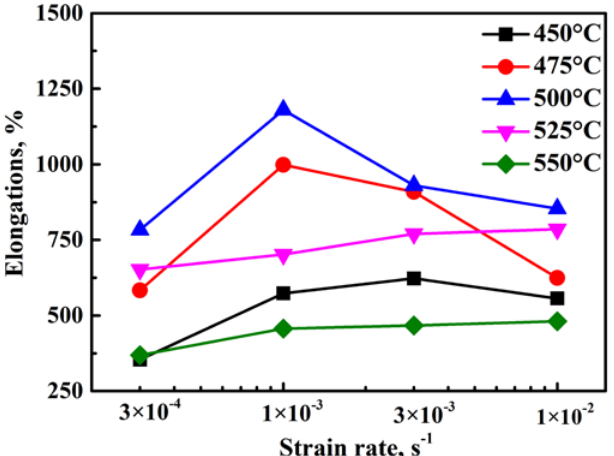
Figure 4. The variations in elongations against the strain rates at the temperatures of 450, 475, 500, 525 and 550 °C.